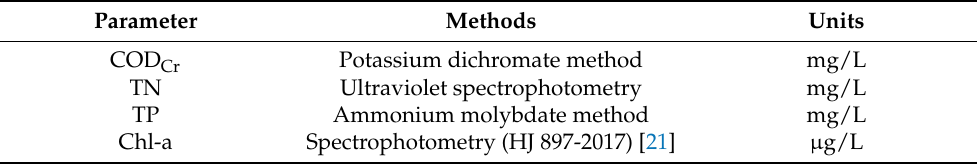
Figure 1. Sampling sites of overlying water in Shahu Lake. Table 1. Analytical methods for selected parameters of water samples (GB3838-2002) [20].